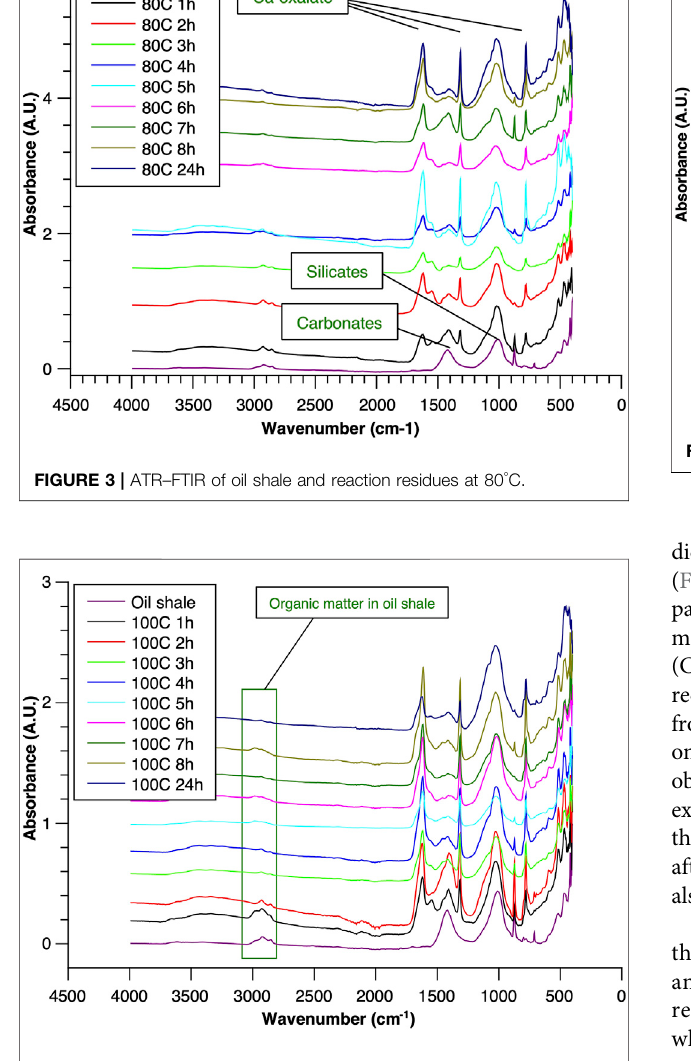
FIGURE 4 | ATR – FTIR of oil shale and reaction residues at 100 ° C.